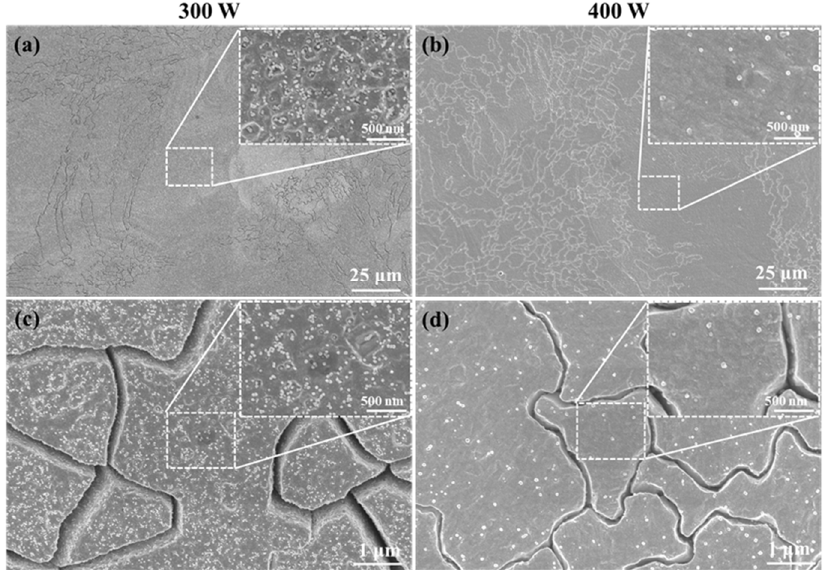
Figure 14. The second phase on the XY plane of Cu–Cr–Nb–Ti alloy samples manufactured using different laser powers at a scanning speed of 800 mm/s; the upper-right corner shows enlarged images: ( a , b ) are the second phases in the coarse grains in the samples P 300 V 800 and P 400 V 800 manufactured by 300 W and 400 W, respectively; ( c , d ) are the second phases in fine grains in samples.